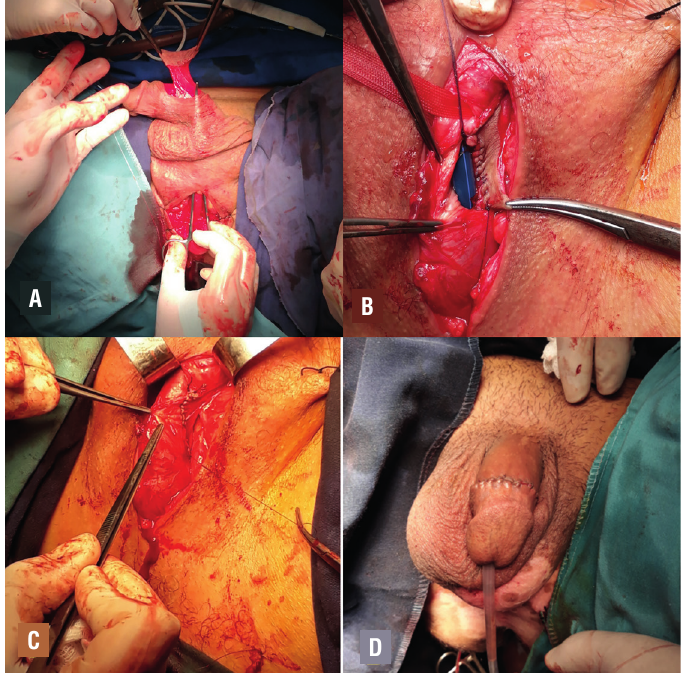
Figure 2A - The flap is passed through a scrotal tunnel to the bulb without torsion and without placing excessive tension on the pedicle; Figure 2B - The flap is sutured to the adjoining edges of urethra; Figure 2C - Final aspect of urethra, Figure 2D - Final aspect of the